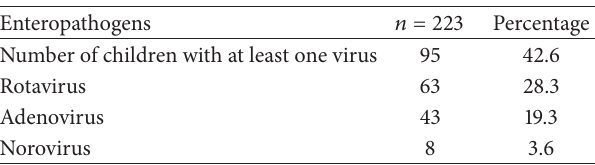
Table 1: Prevalence of three enteric viruses among children with